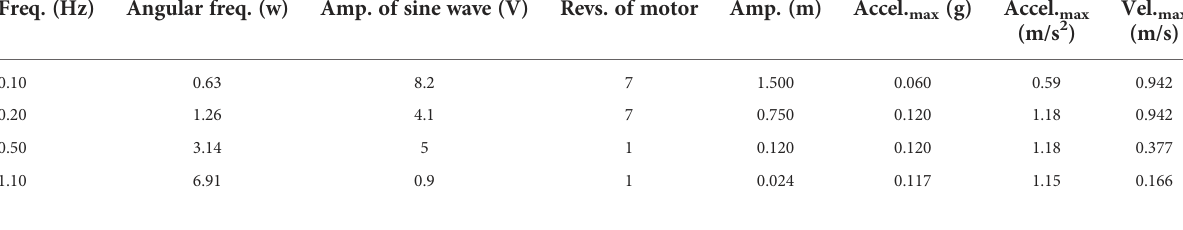
TABLE 1 Con fi guration of motion